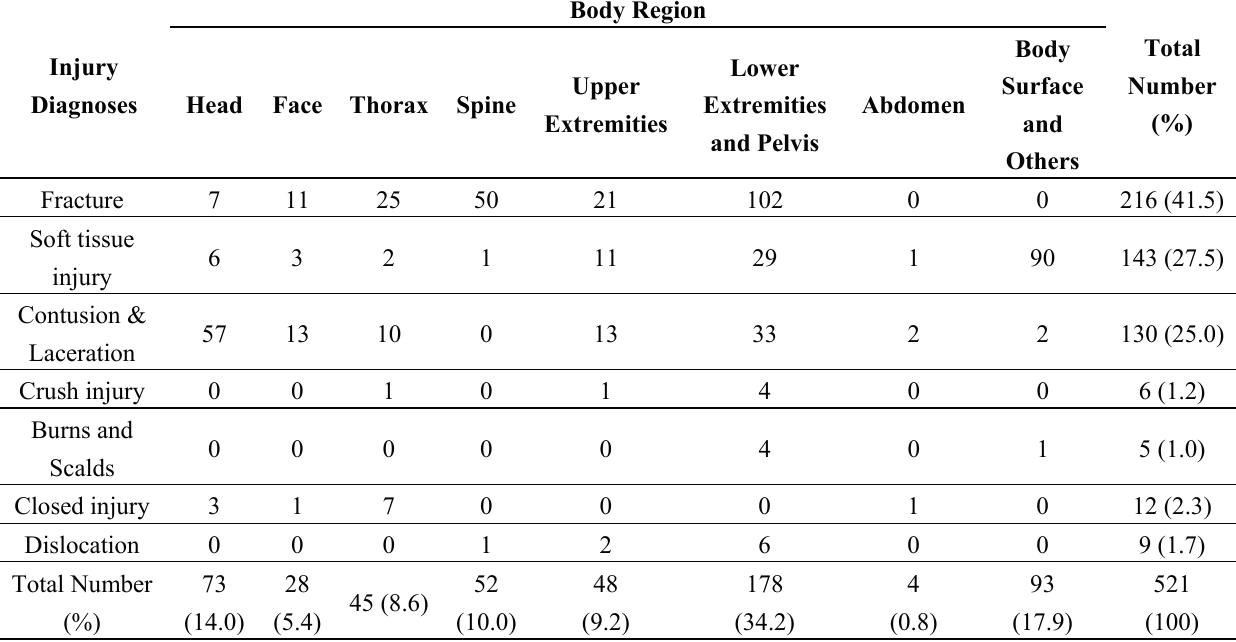
Table 2. Diagnoses by body region of 521 injury diagnoses in admitted patients with earthquake-related